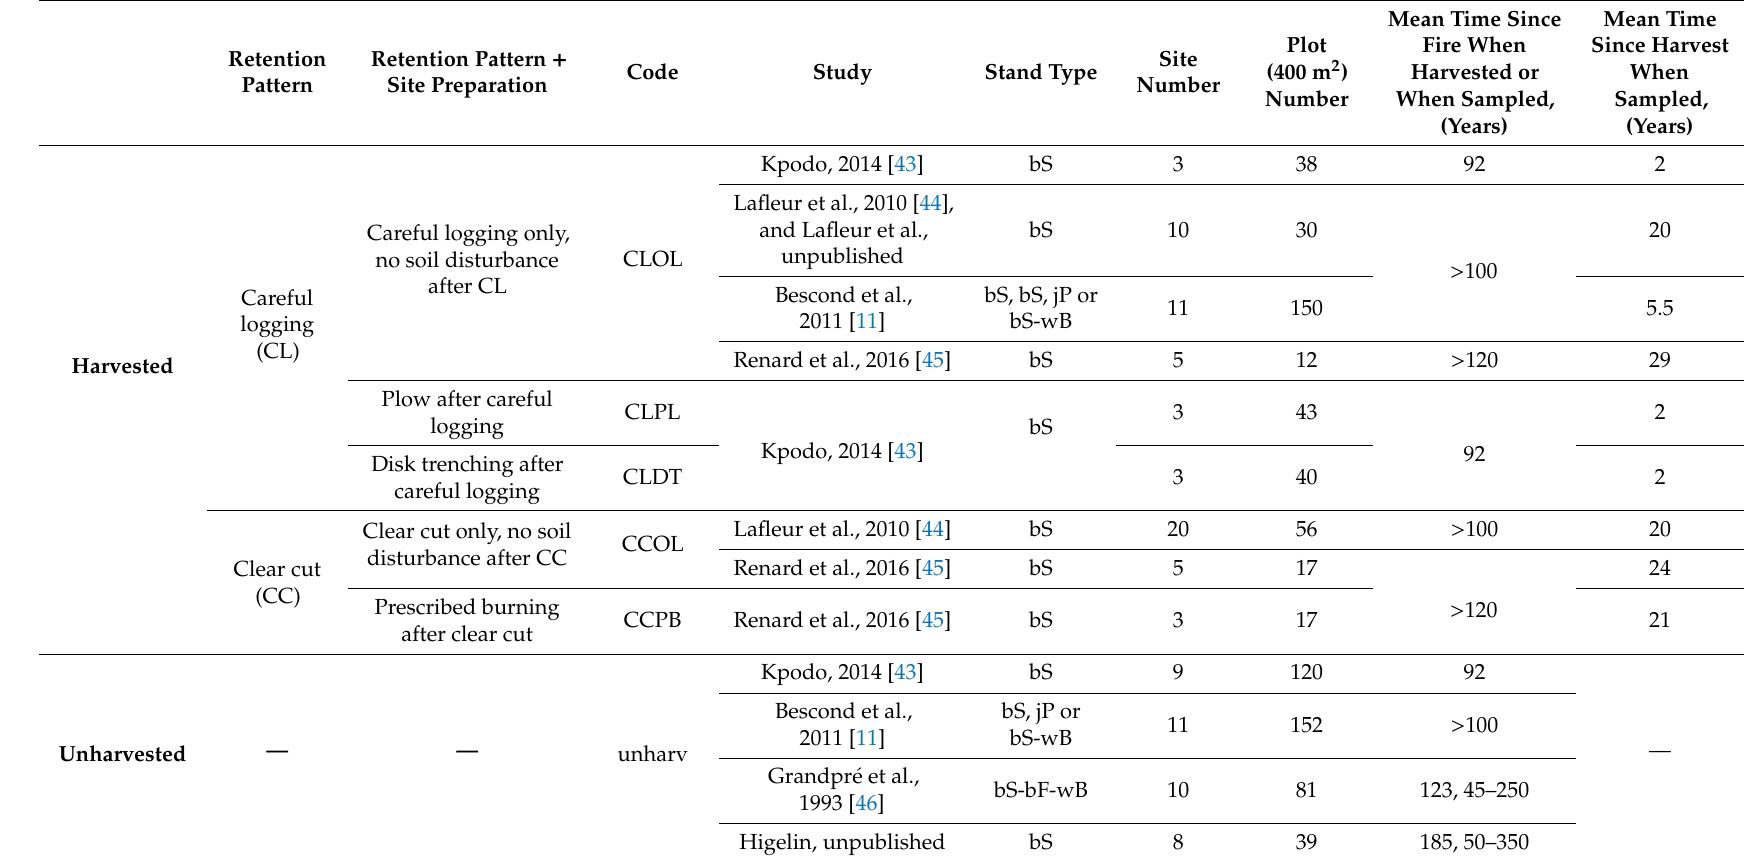
Table 1. Sample size and site characteristics of the variables in di ff erent